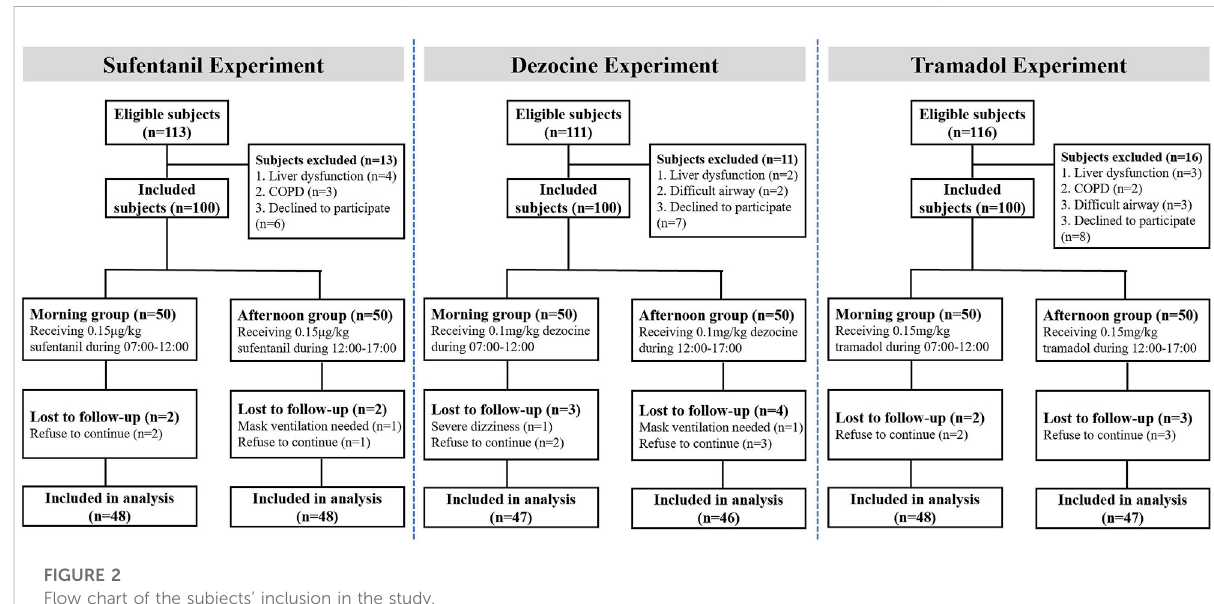
FIGURE 2 Flow chart of the subjects ’ inclusion in the study.